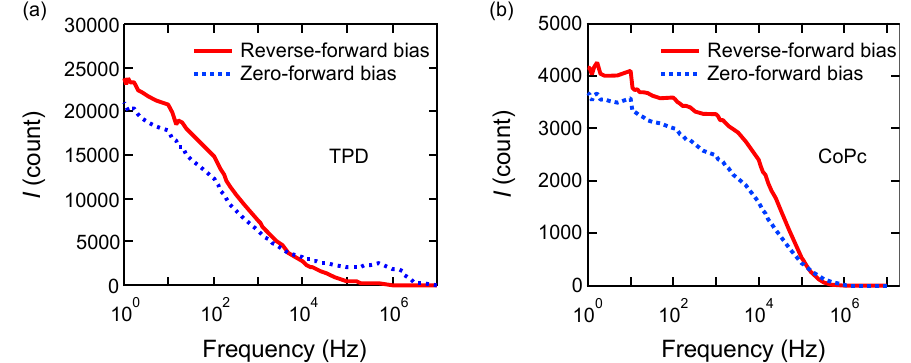
Figure 2. Emission intensity I versus the frequency f of the voltage for the ITO/TPD/Alq 3 /Al device ( a ) and ITO/CoPc/Alq 3 /Al device ( b ). The solid and dashed lines indicate the emission intensity under − 10 and 10 V (reverse-forward) bias and 0 and 10 V (zero-forward) bias, respectively.